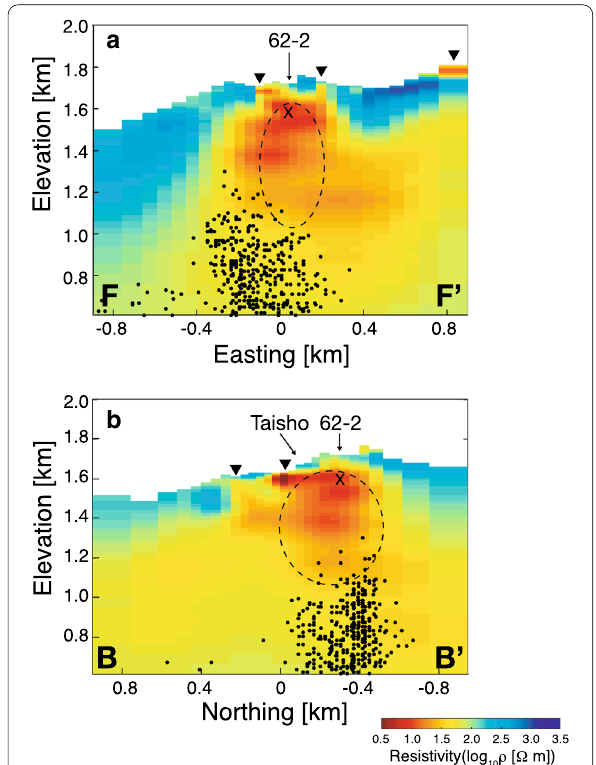
Fig. 4 Vertical cross-section of the three-dimensional (3-D) resistivity structure with the corresponding sources of geophysical phenomena. a Cross-section of the study area in the E–W direction at NS 250 m. b Cross-section of the study area in the N–S direction = − at EW 0 m. The hypocenters located within 250 m of each = ± profile are denoted by black dots. The cross symbol indicates the demagnetization source, as identified by Hashimoto et al. (2010). The region enclosed by the black dashed line denotes the area including the ground inflation source located by the Regional Volcanic Observation and Warning Center, Sapporo Regional Headquarters, JMA